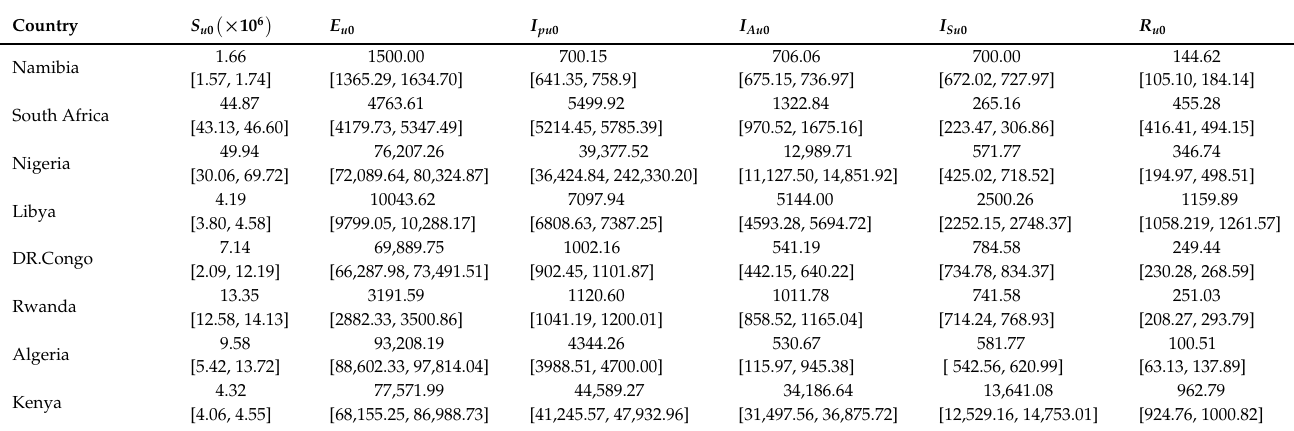
Table A4. Values for the Initial conditions for the state variables and 95% CI .